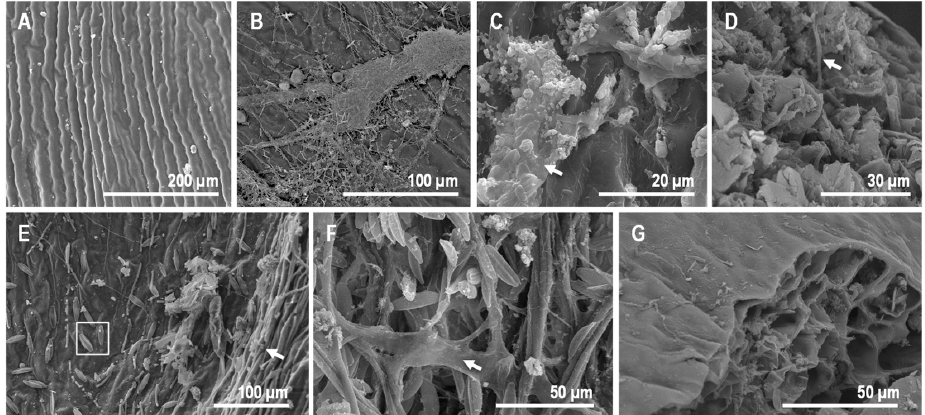
Figure 7. Observations of fern pinna using SEM. ( A ) External view of the upper side of the sample at day 0. ( B ) Control at day 30, with the top (upper surface) partially covered by fungi filaments. ( C ) At day 60, controls showed abundant extracellular polymeric substances (EPS) covering the surface. This EPS trapped some sediment particles (arrow). ( D ) The transverse section of the control at day 60 exposed fungi filaments inside the fern tissues (arrow). ( E ) Some cyanobacterial filaments (arrow) and diatoms (dotted round) at day 7 on the upper side of the fern frond in mats. ( F ) Fern in mat at day 60, with cyanobacteria and diatoms trapped by EPS (arrow). ( G ) Tissue section of the pinna at day 60, free of microorganisms within cells.